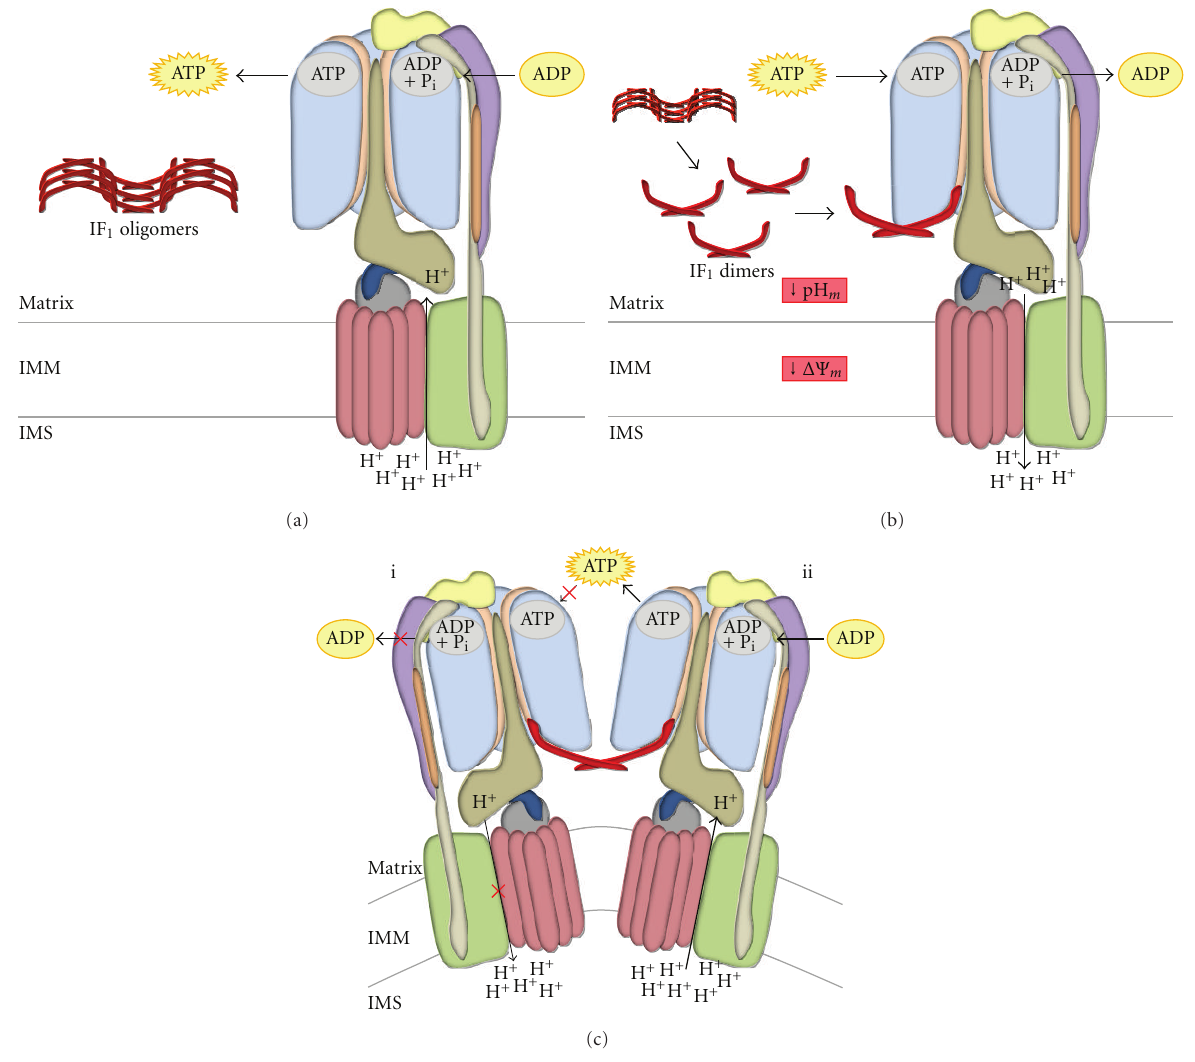
Figure 3: Interaction of IF 1 with the F 1 F o -ATPsynthase. When mitochondria are in normal “energized” conditions (a), the F 1 F o -ATPsynthase can sustain physiological levels of ATP synthesis thanks to the presence of su ffi cient mitochondrial inner membrane potential; in this situation, the matrix pH is slightly basic, and IF 1 is predominantly present in its inactive, oligomeric form. When the electrochemical H + gradient is lost, the F 1 F o -ATPsynthase starts hydrolysing the ATP imported from the cytosol to pump H + back into the intermembrane space (b), restoring ΔΨ m . The augmented [H + ] in the matrix causes a fall in pH that induces the disruption of IF 1 oligomers and the release of free active dimers. The binding of IF 1 dimers at the interface between α - and β -subunits of the F 1 domain is responsible for the selective inhibition of ATP hydrolysis (c–i), while its synthesis is not a ff ected (c–ii). Active IF 1 is able to interact with two F 1 domains at the same time, inducing the dimerization of the F 1 F o -ATPsynthase (c), with subsequent increased enzymatic performance and cristae